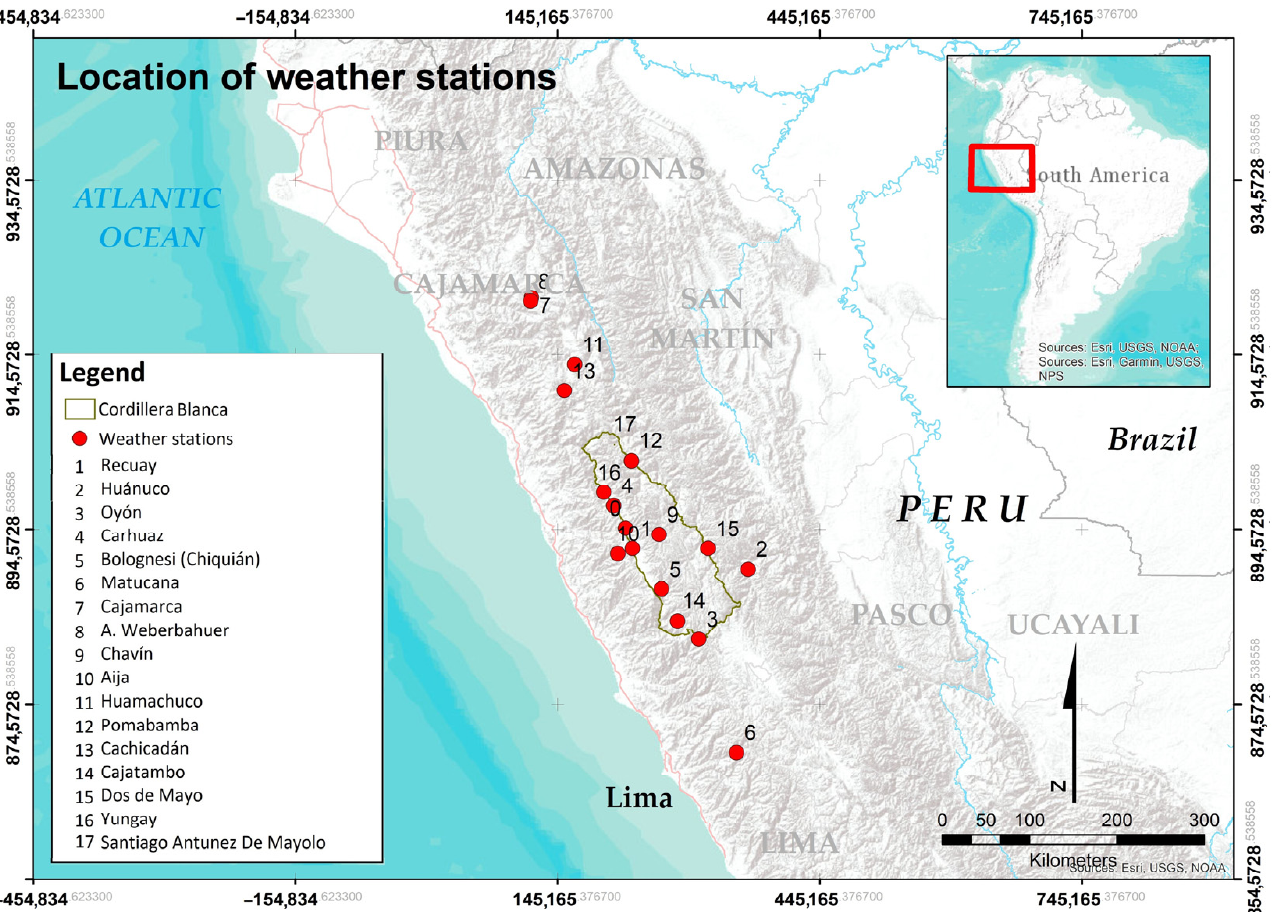
Figure 1. Location of the weather stations of Cordillera Blanca and surrounding areas.